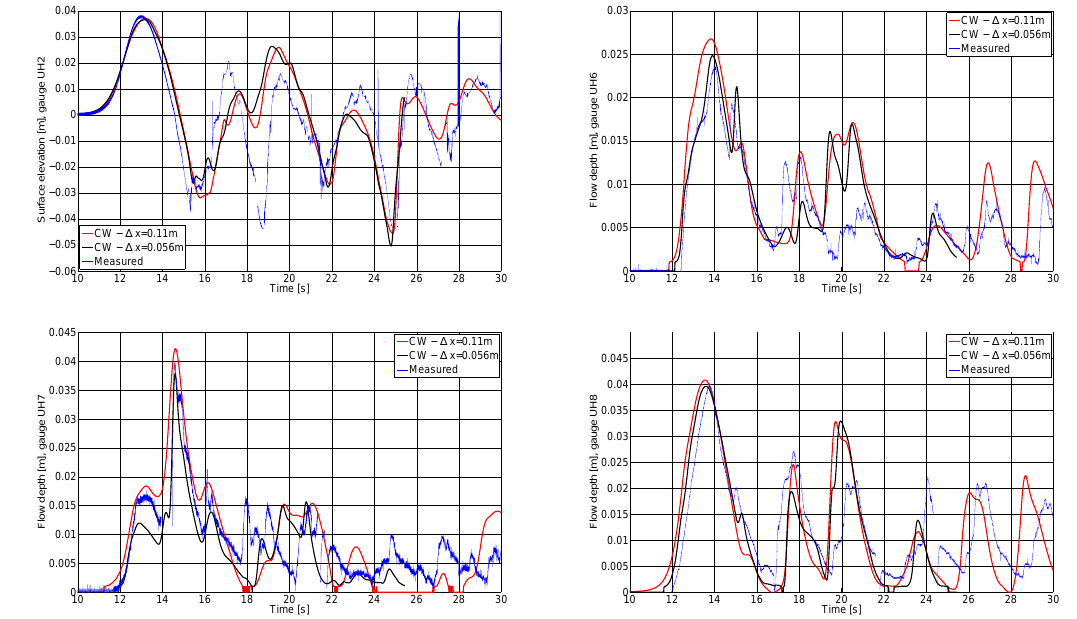
Figure 6. Simulated near-shore wave evolution and inundation compared to measured signals at Hellesylt using Coulwave.